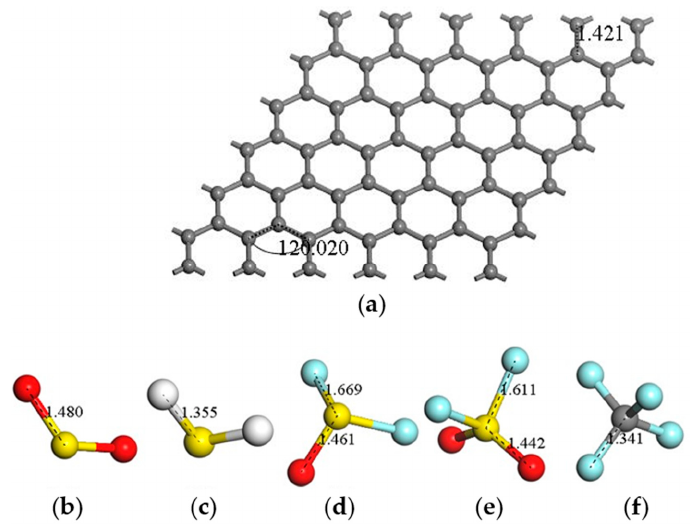
Figure 1. Geometric structures after optimization: ( a ) intrinsic grapheme; ( b ) SO 2 molecule; ( c ) H 2 S molecule; (d ) SOF 2 molecule; ( e ) SO 2 F 2 molecule; and ( f ) CF 4 molecule (distances in Å).